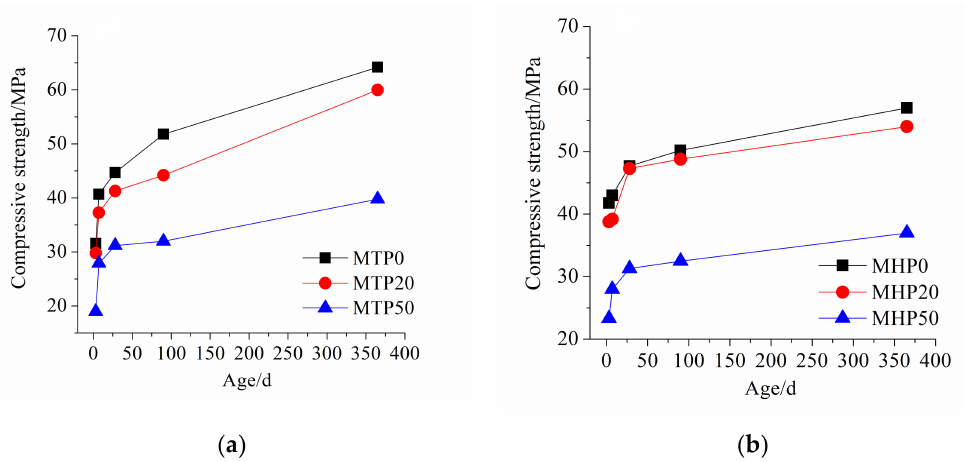
Figure 12. Compressive strength of cement-ITP mortar at different curing temperatures. ( a ) 20 ◦ C and ( b ) 60 ◦